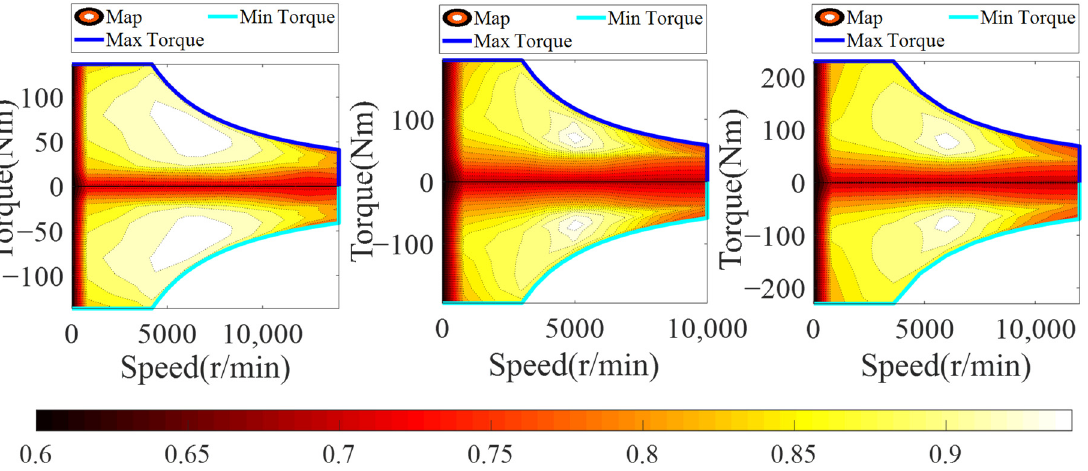
Figure 3. Efficiency maps of front/rear motors and generator.